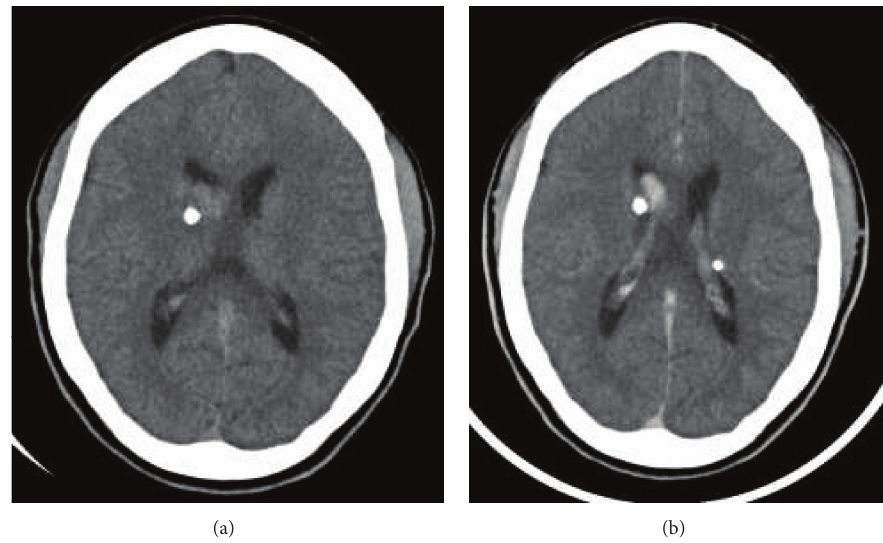
Figure 1: Axial noncontrast CT demonstrating a 12 × 18 mm partially calcified, enhancing soft tissue mass in the anterior body of the right lateral ventricle (a). Axial CT with contrast showing SEGA enhancement but no enhancement of tubers